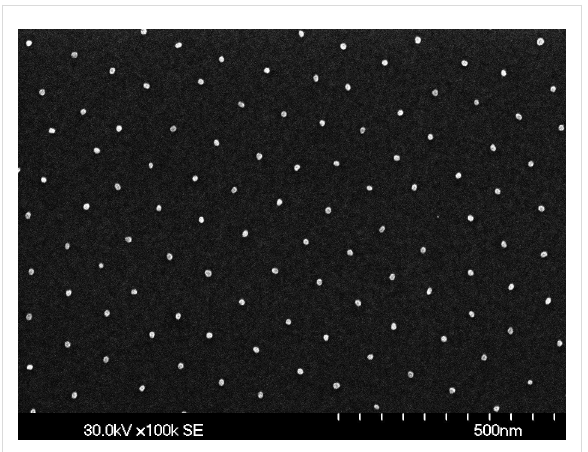
Figure 1: SEM image of Au nanoparticles (average diameter 13 nm, interparticle distance 102 nm) deposited on top of a Si substrate by applying an approach based on self-organization of precursor-loaded reverse